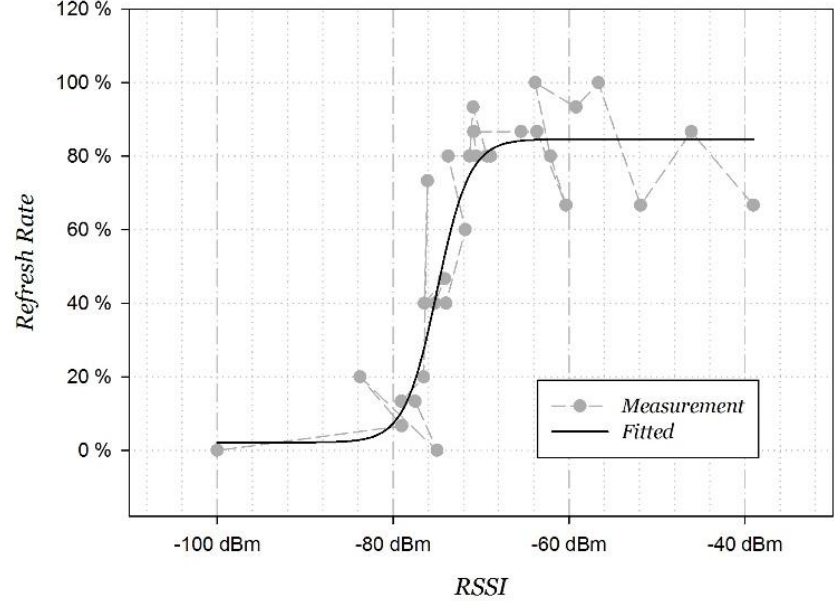
Figure 3. Curve fitting refresh rate function.